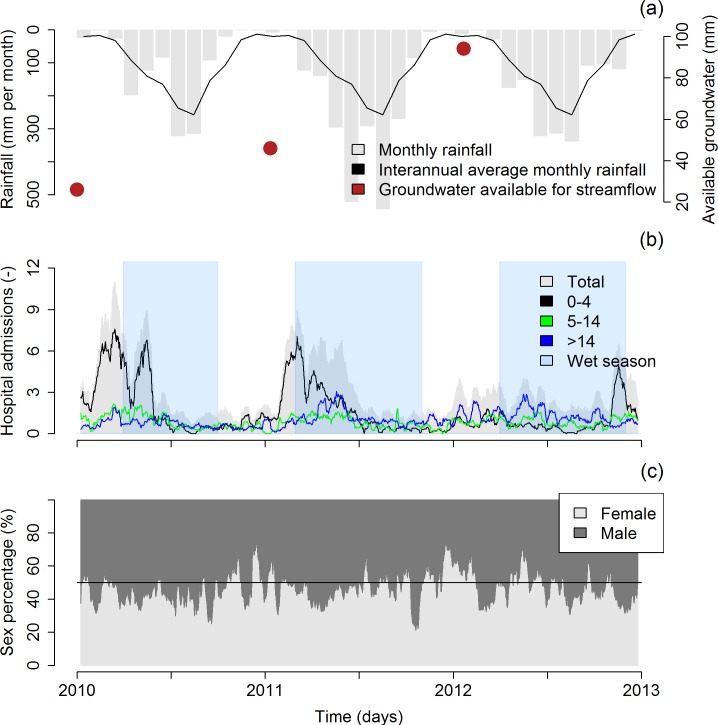
(a) Cumulated rainfall per month (mm) at Luang Prabang, interannual average monthly rainfall (mm) at Luang Prabang and groundwater available for streamflow (mm) in Houay Pano, (b) 15-day moving average of the reported diarrhea cases (i.e., hospital admissions for total, and for the 0–4, 5–14 and >14 age groups), and (c) sex percentage of the diarrhea cases.